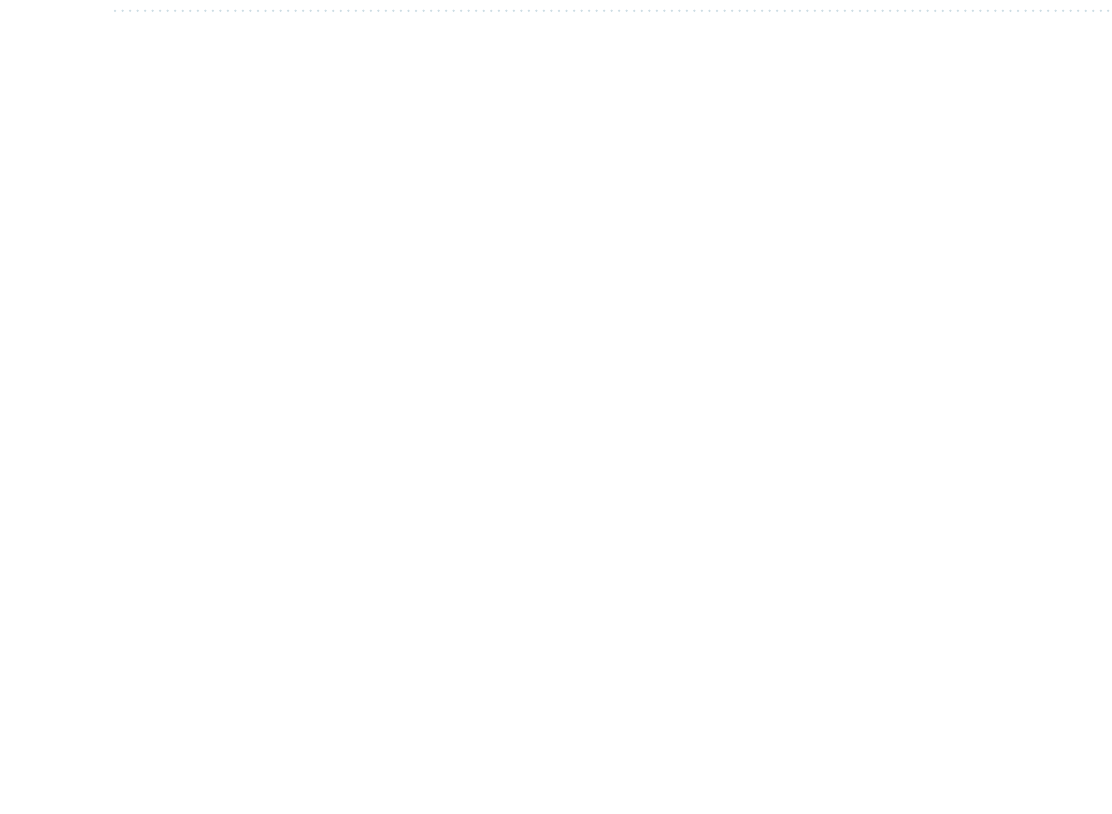
Figure 3. Impacts of (cid:31) on Y ′ (ζ) for ( a ) opposing ( b ) assisting and ( c ) static